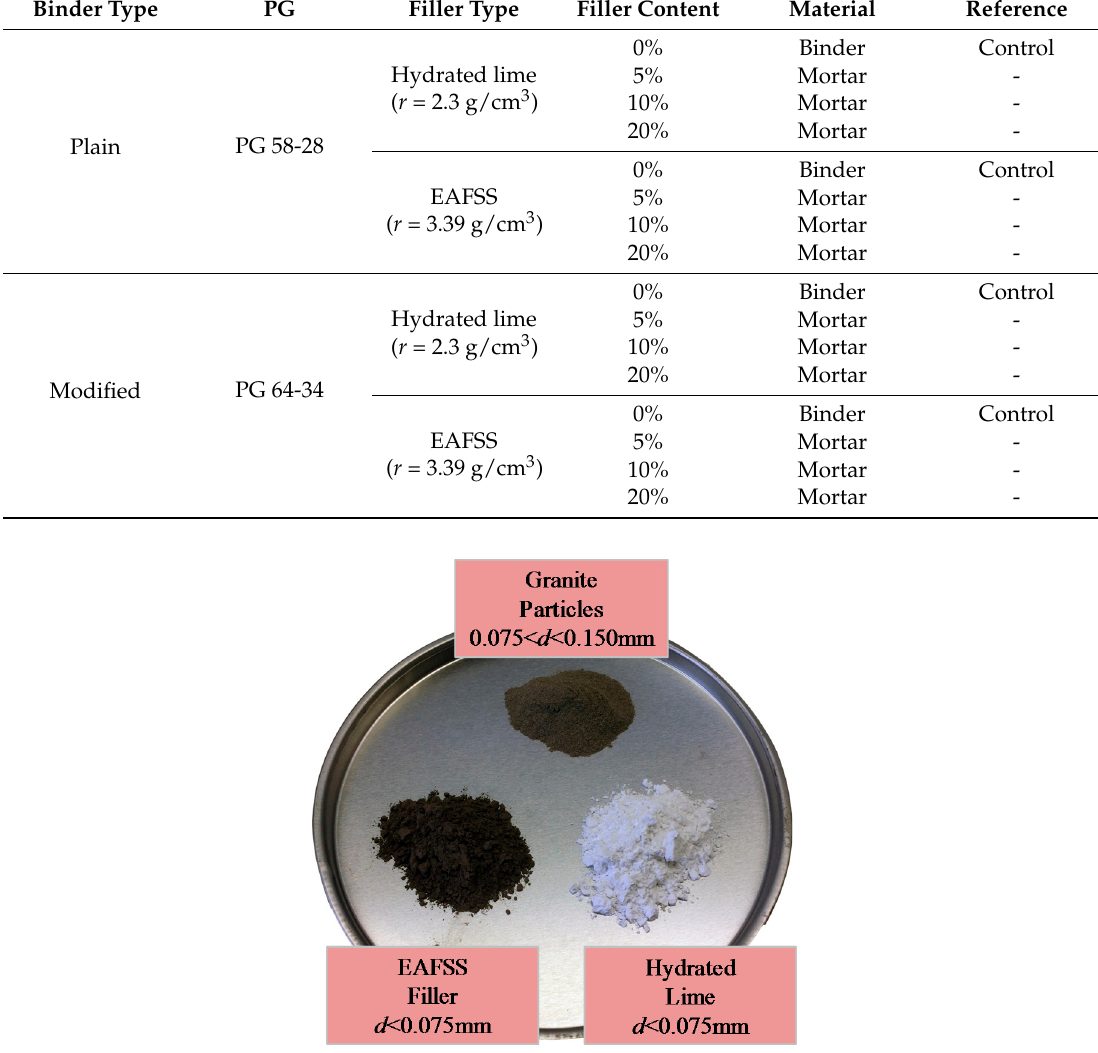
Figure 2. Granite, EAFSS, and hydrated lime particles.